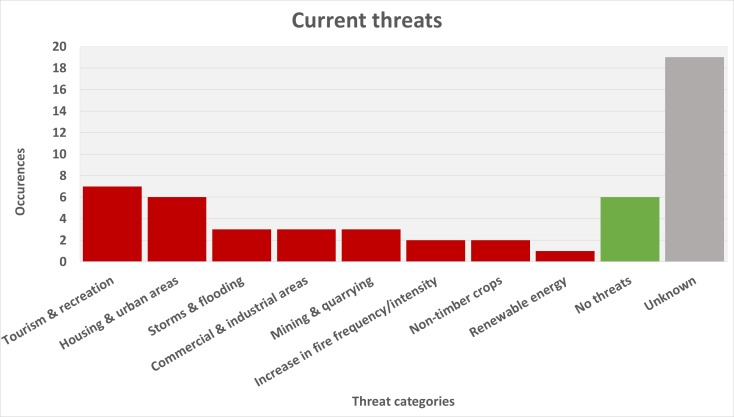
Threat categories amongst all species.